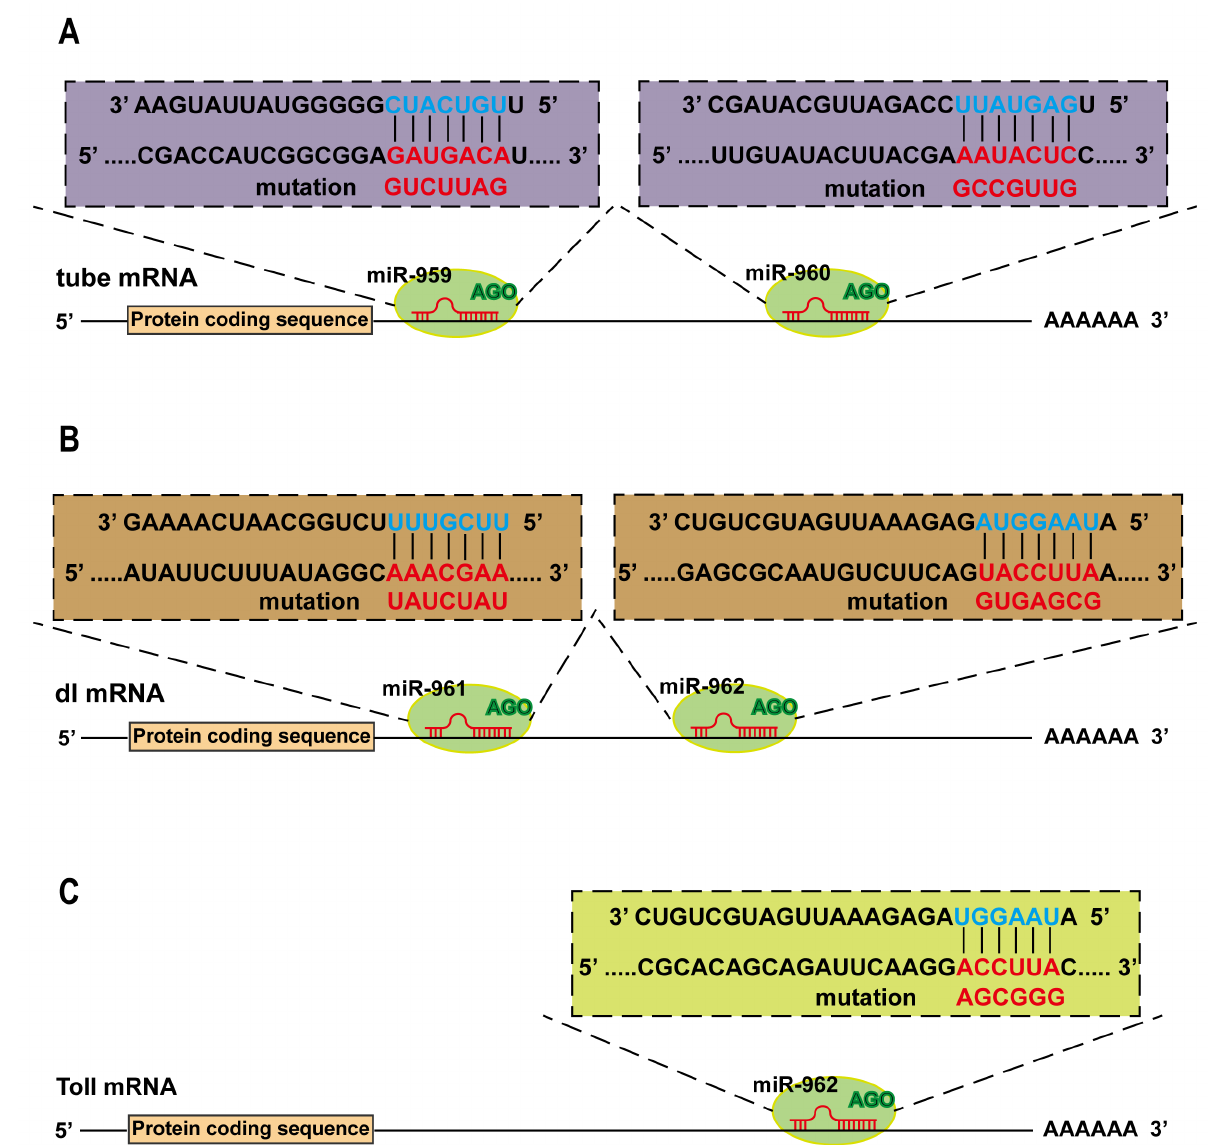
Figure 4. The target genes of four miRNA members from miR-959–962 clusters were predicted. The potential binding sites of miR-959, miR-960, miR-961, and miR-962 in the 3 (cid:48) UTR of tube ( A ), dl ( B ) and Toll ( C ) were present, respectively. The point mutations (red) at the 3 (cid:48) UTR target sites base pairing to the seed sequence of corresponding miRNA (blue) were